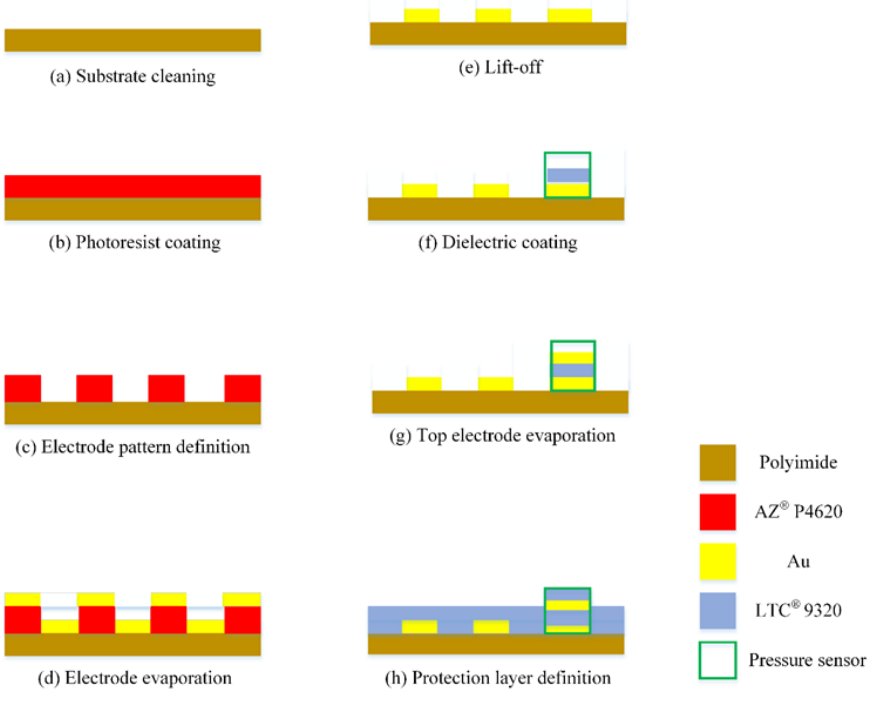
Figure 1. Manufacturing process of flexible three-in-one microsensor.